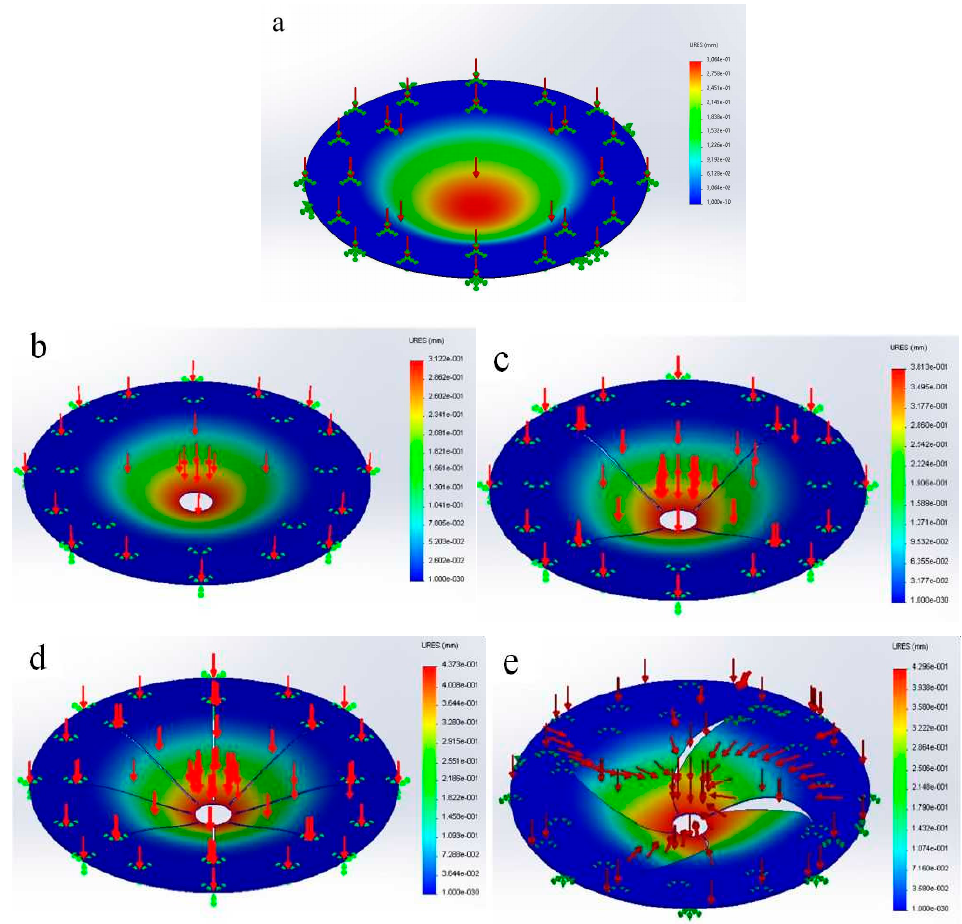
Figure 3. Finite element simulations of deflections (extant as color scales) resulting from a uniform constant pressure of 0.7 kPa on the membranes ( a ) M1, ( b ) M2, ( c ) M3, ( d ) M4 and ( e ) M5. The arrows on the membrane symbolize the vertical pressure on each point of the membrane. The green dotted points refer to the part of the membrane being fixed (1 cm from the edge), as under the experimental conditions.